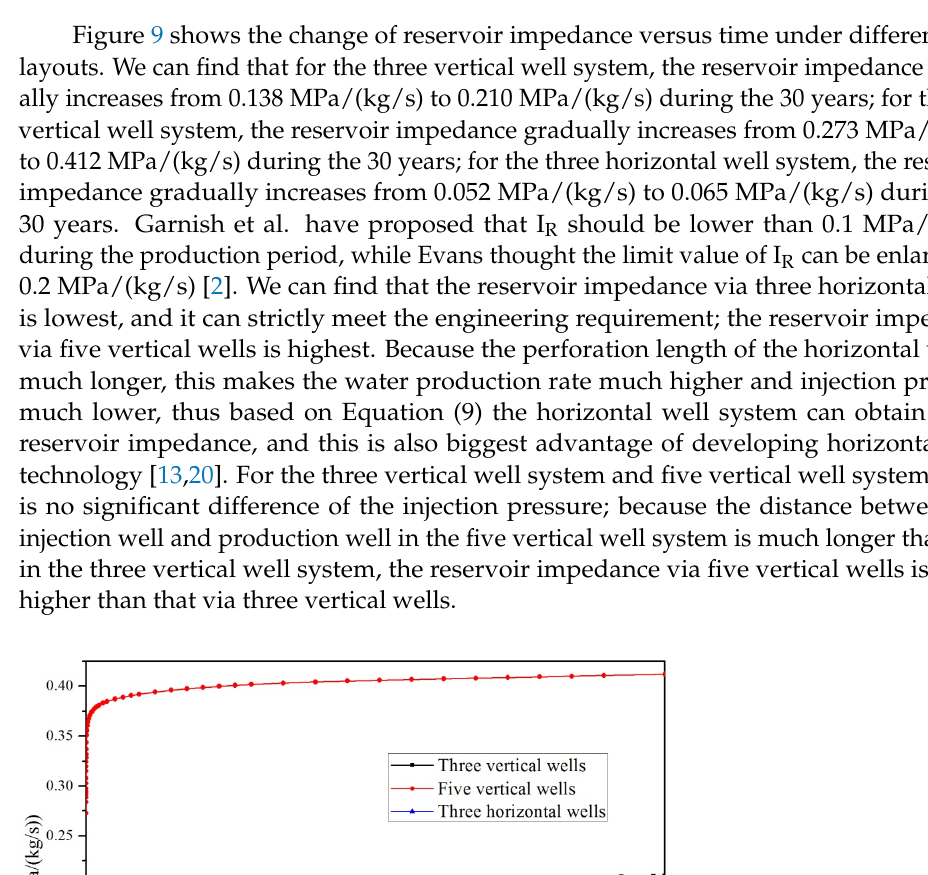
Figure 8. The change of energy efficiency versus time under different well layouts.